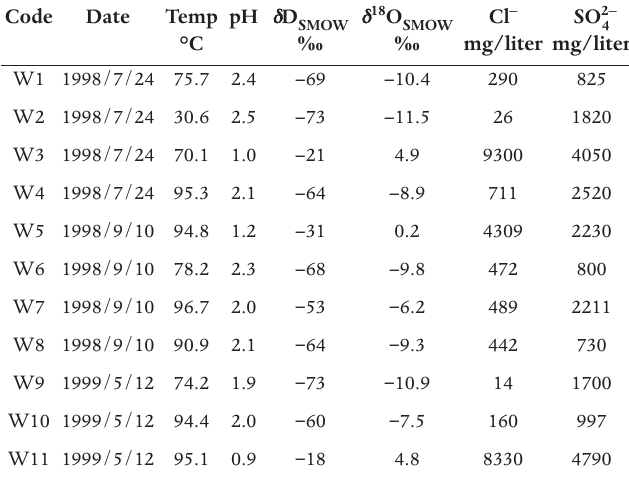
Table 2. Chemical and isotopic compositions of the hot spring waters sampled at site J.